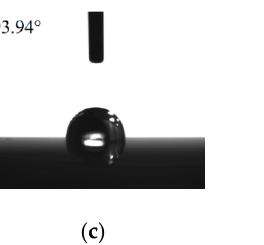
Figure 3. Water contact angles of ( a ) FeCoNiCr medium-entropy alloy (MEA), ( b ) APPJ-treated FeCoNiCr MEA, ( c ) OTS-coated APPJ-treated FeCoNiCr MEA, and ( d ) OTS-coated FeCoNiCr MEA.